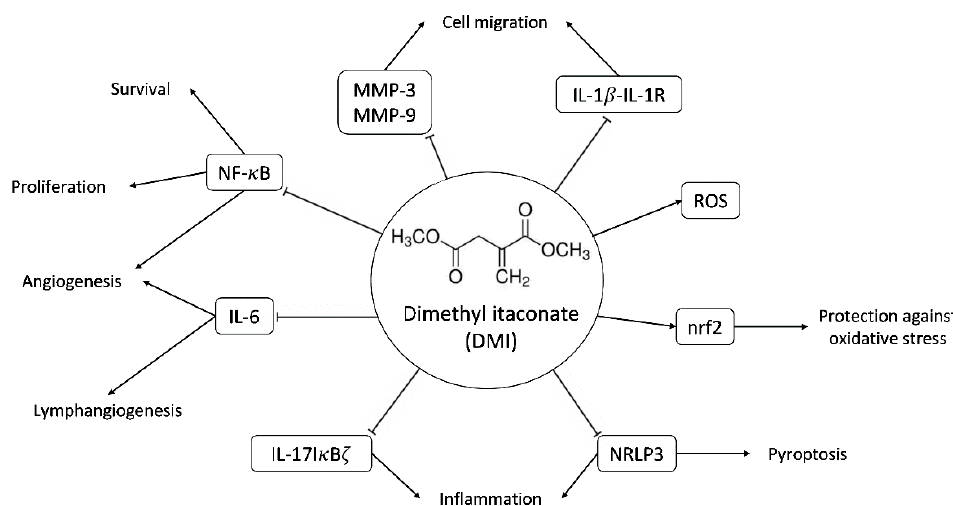
Figure 1. Scheme of some of the molecular targets of DMI and their biological effects. Abbreviations: matrix metalloproteinase-3 and -9 (MMP-3 and MMP-9), interleukin-1beta-interleukin 1 receptor (IL-1 β -IL-1R), reactive oxygen species (ROS), nuclear factor-erythroid factor 2-related factor 2 (nrf2), nuclear factor kappa B (NF- κ B), interleukin-6 (IL-6), interleukin-17 NF-kappa-B inhibitor zeta (IL-17-I κ B ζ ), NLR family pyrin domain containing 3 (NLRP3).